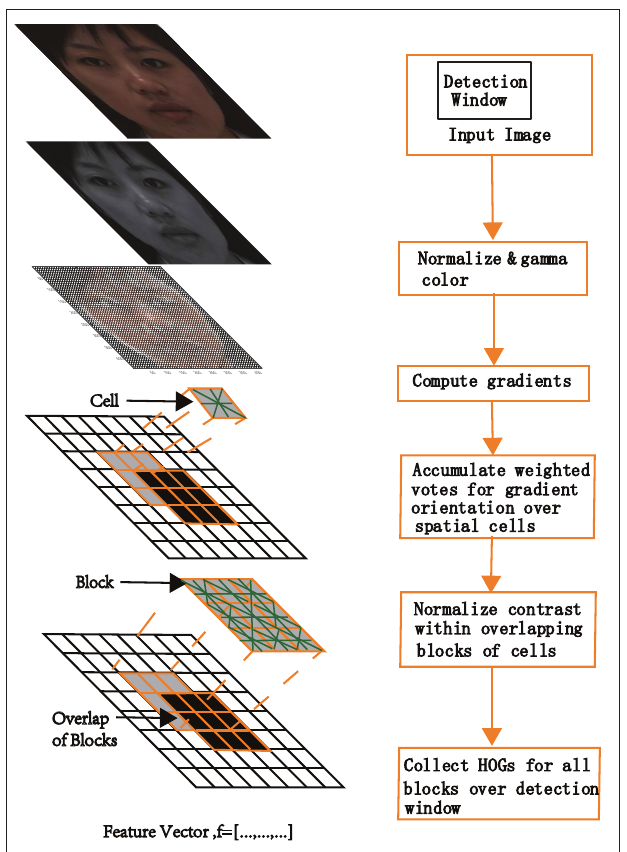
FIGURE 4 | The model schematic of HOG algorithm.